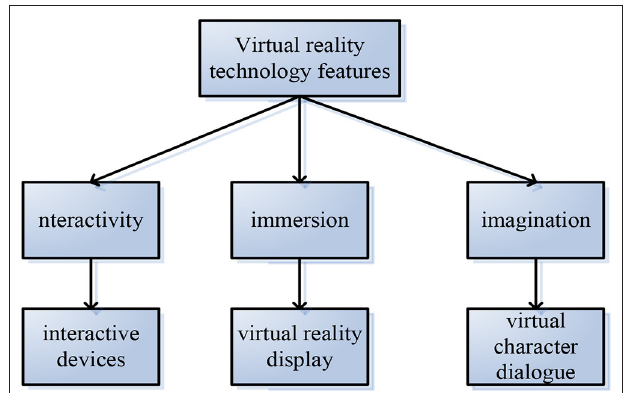
FIGURE 5 | Characteristics of VR technology.